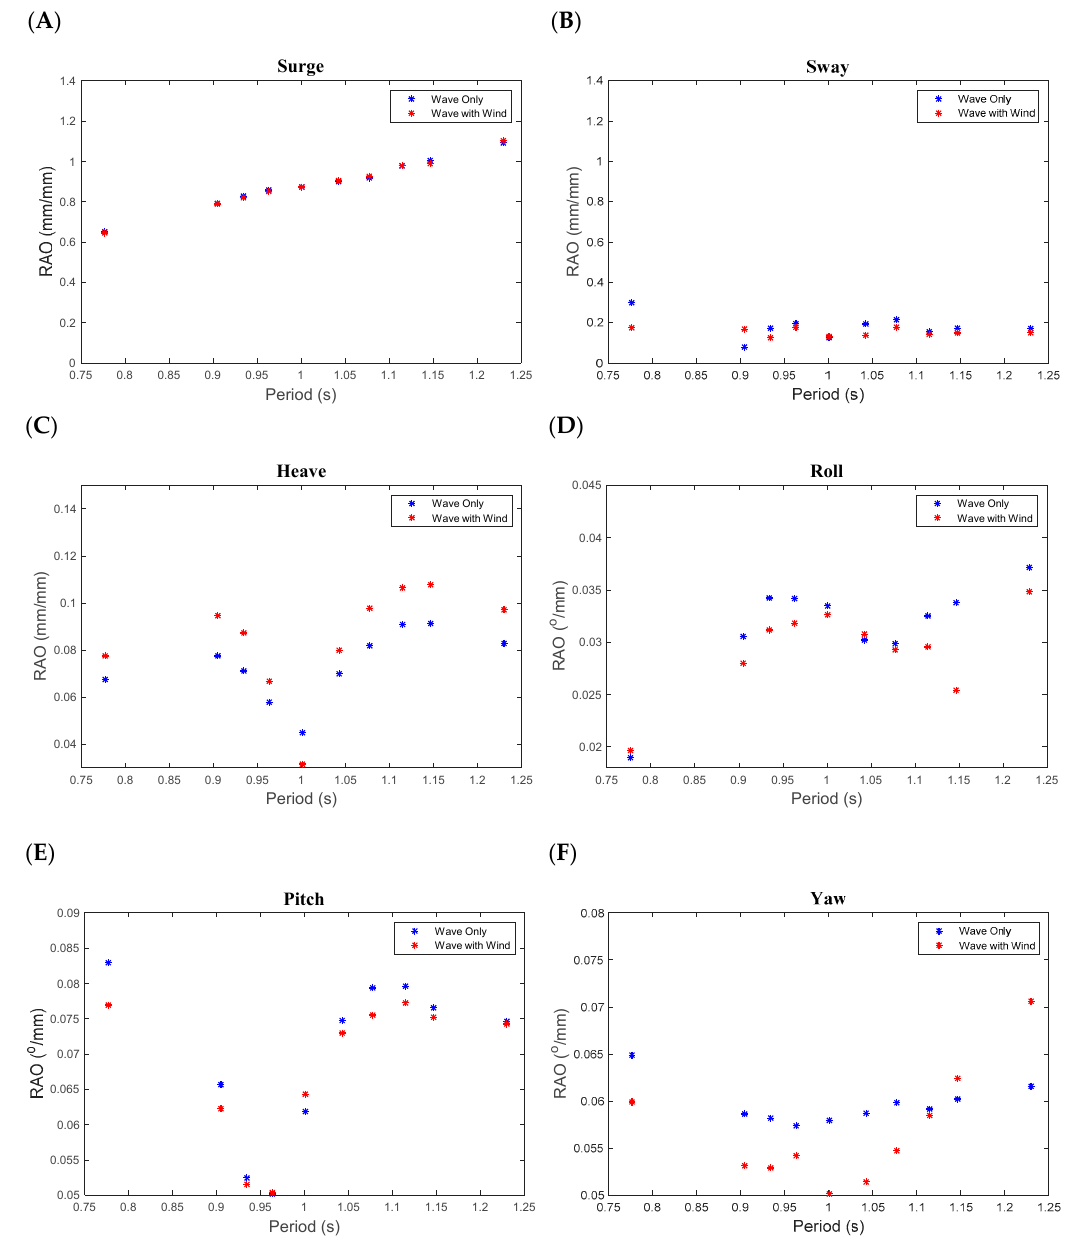
Figure 13. Motion response amplitude operators for each degree of freedom: Surge RAO ( A ), sway RAO ( B ), heave RAO ( C ), roll RAO ( D ), pitch RAO ( E ) and yaw RAO ( F ).